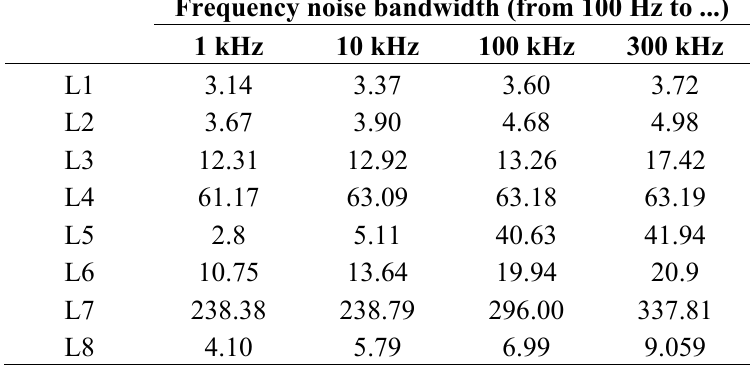
Table 5. RMS values of frequency noise vs . frequency bandwidth [kHz/(Hz) 1/2 ]. Starting frequency of the considered band is 100 Hz.